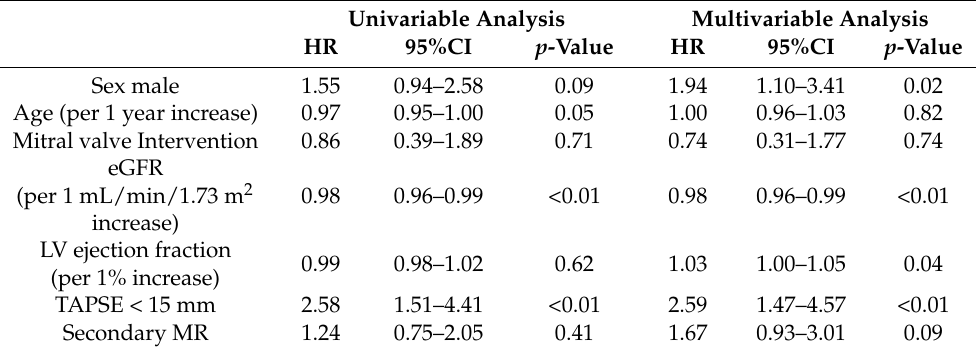
Table 6. Association of mitral valve intervention with one-year all-cause mortality. Univariable Analysis Multivariable